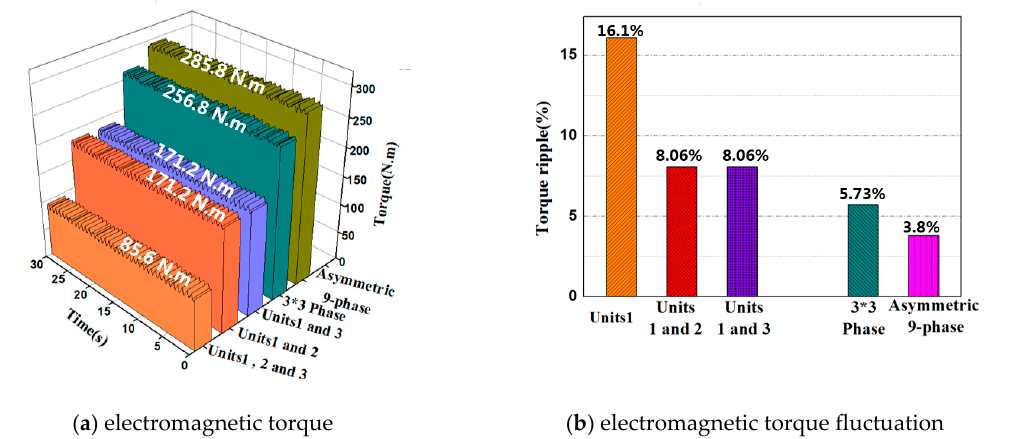
Figure 5. Torque curves of the generators.